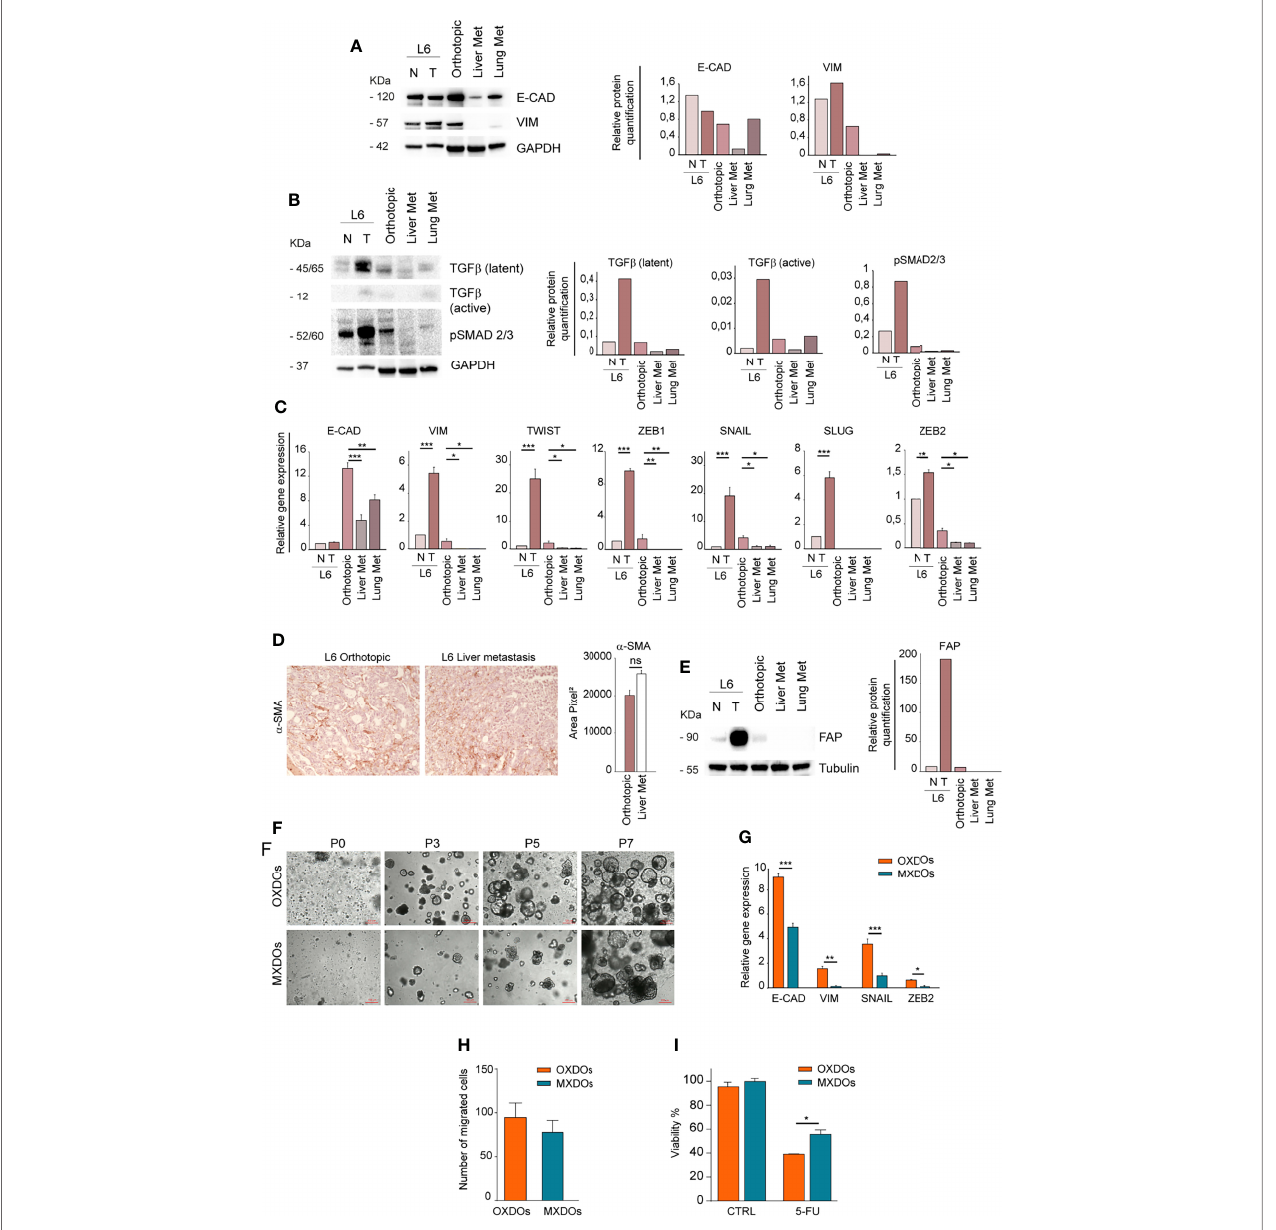
FIGURE 4 | Metastatic tissues lose mesenchymal traits and acquire increased chemoresistance. (A) Left: comparative immunoblot analysis of E-Cadherin (E-CAD) and Vimentin (VIM) on whole lysates of normal/peritumoral mucosa (N) and tumor tissue (T) of patient L6, orthotopic xenograft (Orthotopic), liver and lung xenograft metastases (Liver Met and Lung Met). GAPDH was used as a loading control. Right: quanti fi cation of the immunoblot experiment shown on the left. (B) Left: comparative immunoblot analysis of phosphorylated SMAD 2/3 (pSMAD 2/3) and TGF- b on whole lysates as described above. Right: quanti fi cation of the immunoblot experiment shown on the left. (C) qRT-PCR analysis of E-Cadherin (E-CAD), Vimentin (VIM), Twist, ZEB1, SNAIL, SLUG, and ZEB2 in normal/peritumoral mucosa (N) and tumor tissue (T) of patient L6, orthotopic xenograft (Orthotopic), liver and lung xenograft metastases (Liver Met and Lung Met). Mean ± SD of 3 experiments. *P <0.05, **P< 0.01 and ***P< 0.001 from two-tailed Student ’ s t test. (D) Staining of alpha Smooth Muscle Actin ( a SMA) on sections of L6 orthotopic PDX and hepatic metastasis (left) and quanti fi cation of 5 sections (right). Magni fi cation 20x, ns non-signi fi cant. (E) Left: Immunoblot analysis of human Fibroblast Activation Protein (FAP) in normal (N) and tumor (T) parental tissues of L6 patient, in orthotopic PDX (Orthotopic) and metastatic PDX (Liver Met and Lung Met). Tubulin was used as loading control. Right: quanti fi cation of the immunoblot experiment shown on the left. (F) Time course of organoid generation (orthotopic xenograft-derived organoids, OXDOs and metastatic xenograft-derived organoids, MXDOs), from the fi rst day of culture (passage 0, P0) to subsequent passages (P3, P5 and P7, respectively after 3 weeks, 5 weeks and 7 weeks of culture). Magni fi cation 10x. Bar 100 m M. (G) qRT-PCR analysis of E-Cadherin (E-CAD), Vimentin (VIM), SNAIL and ZEB2 on OXDOs (orange bars) and MXDOs (blue bars). *P<0.05, **P<0.01 and ***P<0.001 from two-tailed Student ’ s t test. (H) Invasion/migration assay performed with OXDOs and MXDOs. (I) Cell viability of OXDOs (orange bars) and MXDOs (blue bars) treated with 5 m M 5-Fluorouracil (5-FU) for 6 days. Values represent mean ± SD of three independent experiments. *P < 0.05 by unpaired Student ’ s t